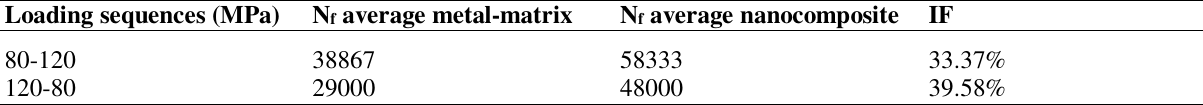
Shows the improvement factor in cumulative fatigue live due to 10wt% Al 2 O 3 . Loading sequences (MPa)